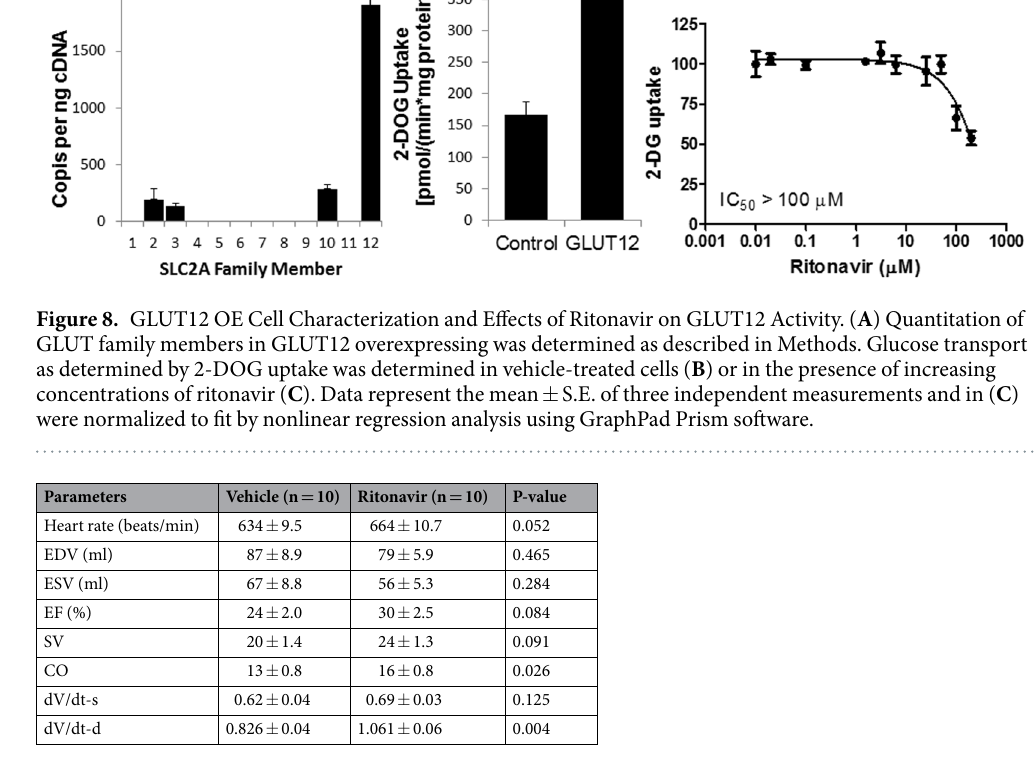
Table 1. Echocardiography results in closed-chest I/R mice treated chronically with ritonavir. Transthoracic echocardiographic images were obtained on conscious C57Bl/6 mice at 2 weeks post ischemia/reperfusion as described in Methods. Data are represented as the average ± SEM (n = 10/group). EDV, end-diastolic LV volume; ESV, end-systolic LV volume; EF, ejection fraction [(EDV–ESV)/EDV]; SV, systolic volume; CO, cardiac output; dV/dt-d, peak rate of LV volume increase in diastole; dV/dt-s, peak rate of LV volume decrease in